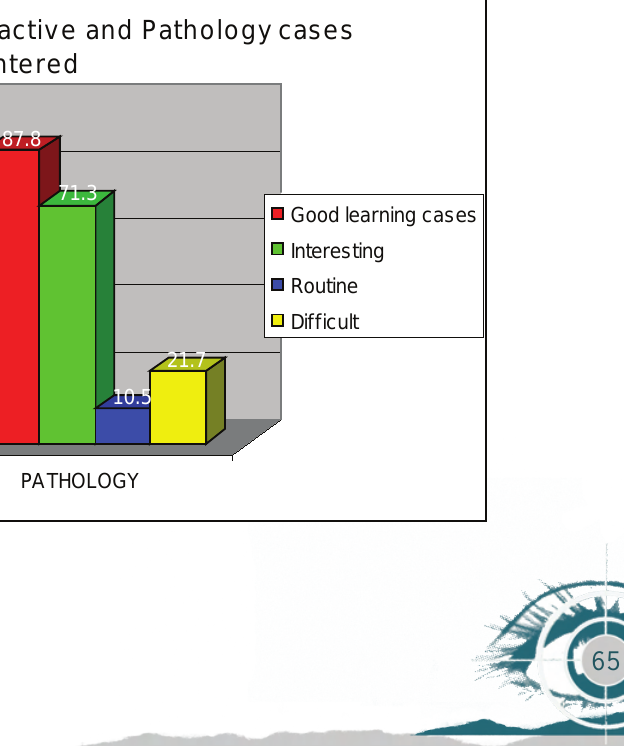
Figure 2: Rating of the Re fractiv e and Pathology case s e ncounte re